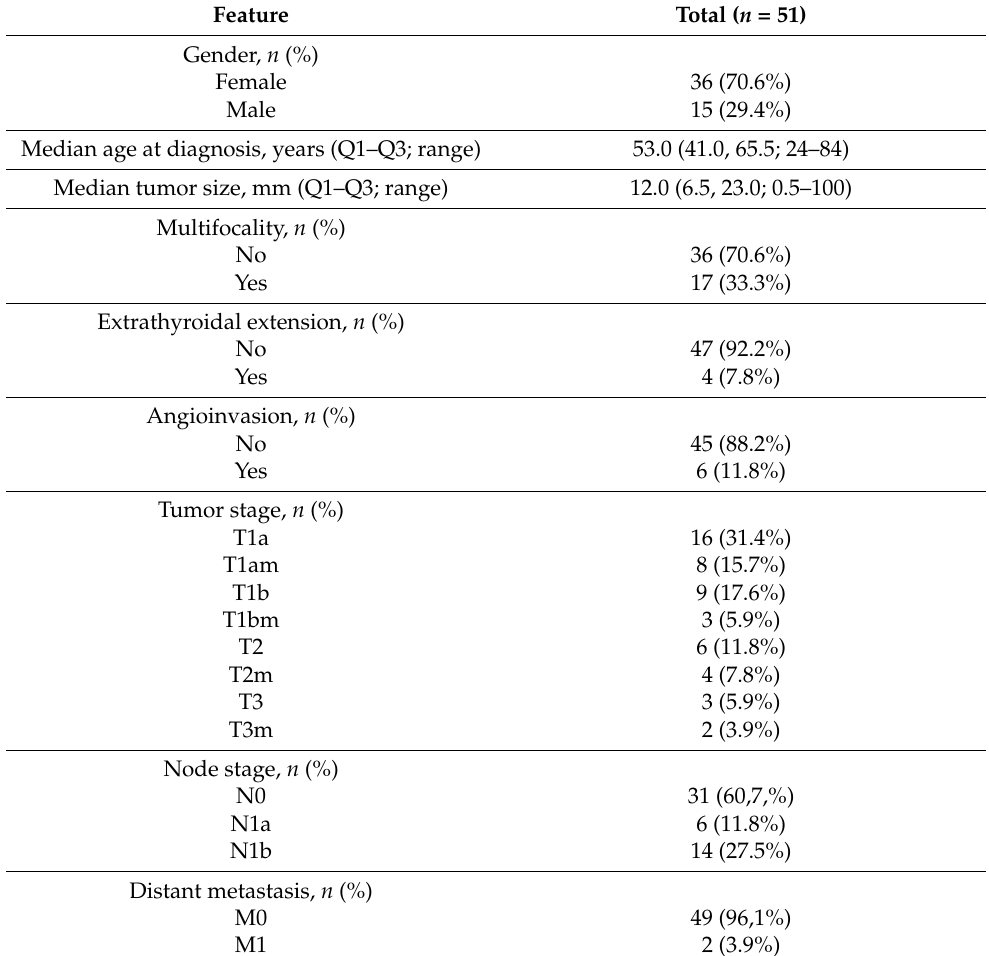
Table 1. Characteristics of the study group.